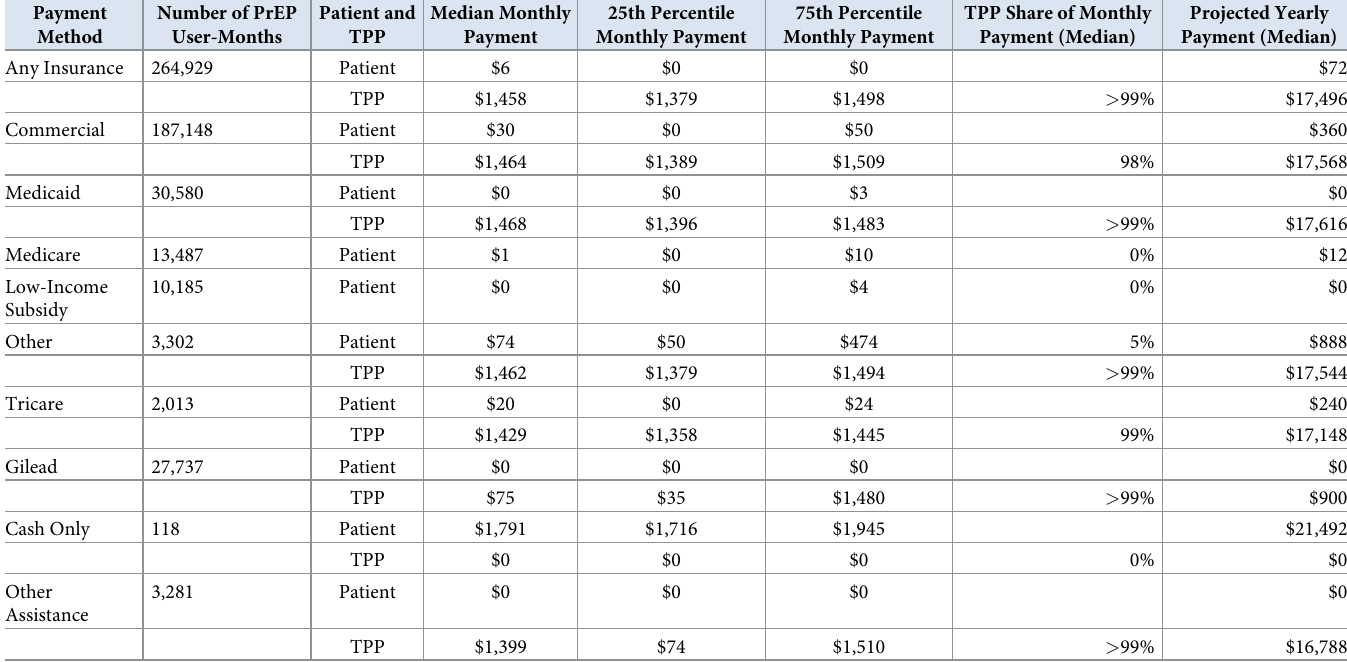
Table 4. Median patient and TPP payments for PrEP by payment method category, September 2015 through August 2016. Payment